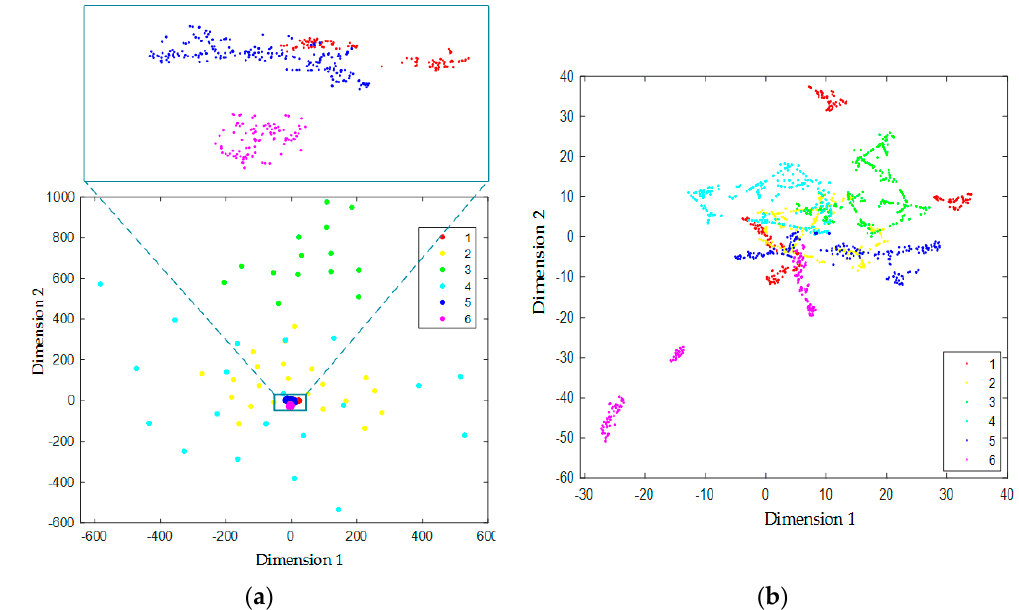
Figure 5. Dimension reduction results of the dataset before and after the data augmentation. ( a ) Dimension reduction results of the dataset before the data augmentation.; ( b ) Dimension reduction results of the dataset after the data augmentation.